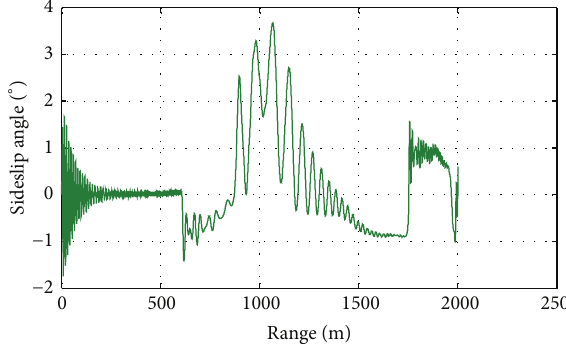
Figure 16: Sideslip